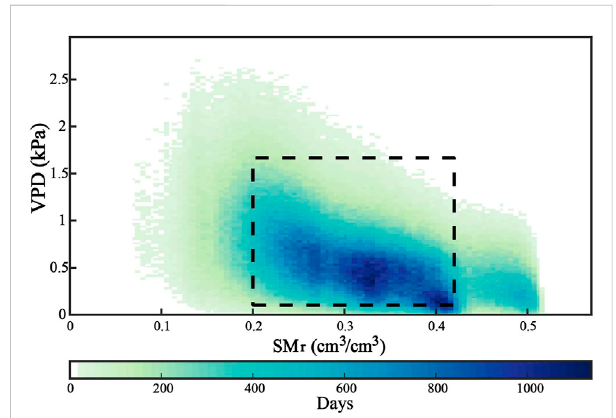
FIGURE 1 Thedistributionofdaily VPD androot-zone soilmoisture(SMr)in China maize growing area from 2010 to 2016. The color indicates the amount of days in each corresponding interval, and the data we use in the yield model shown in is within the dotted box (VPD: 0.1 – 1.67 kPa, SM r : 0.2 – 0.42 cm 3 cm − 3